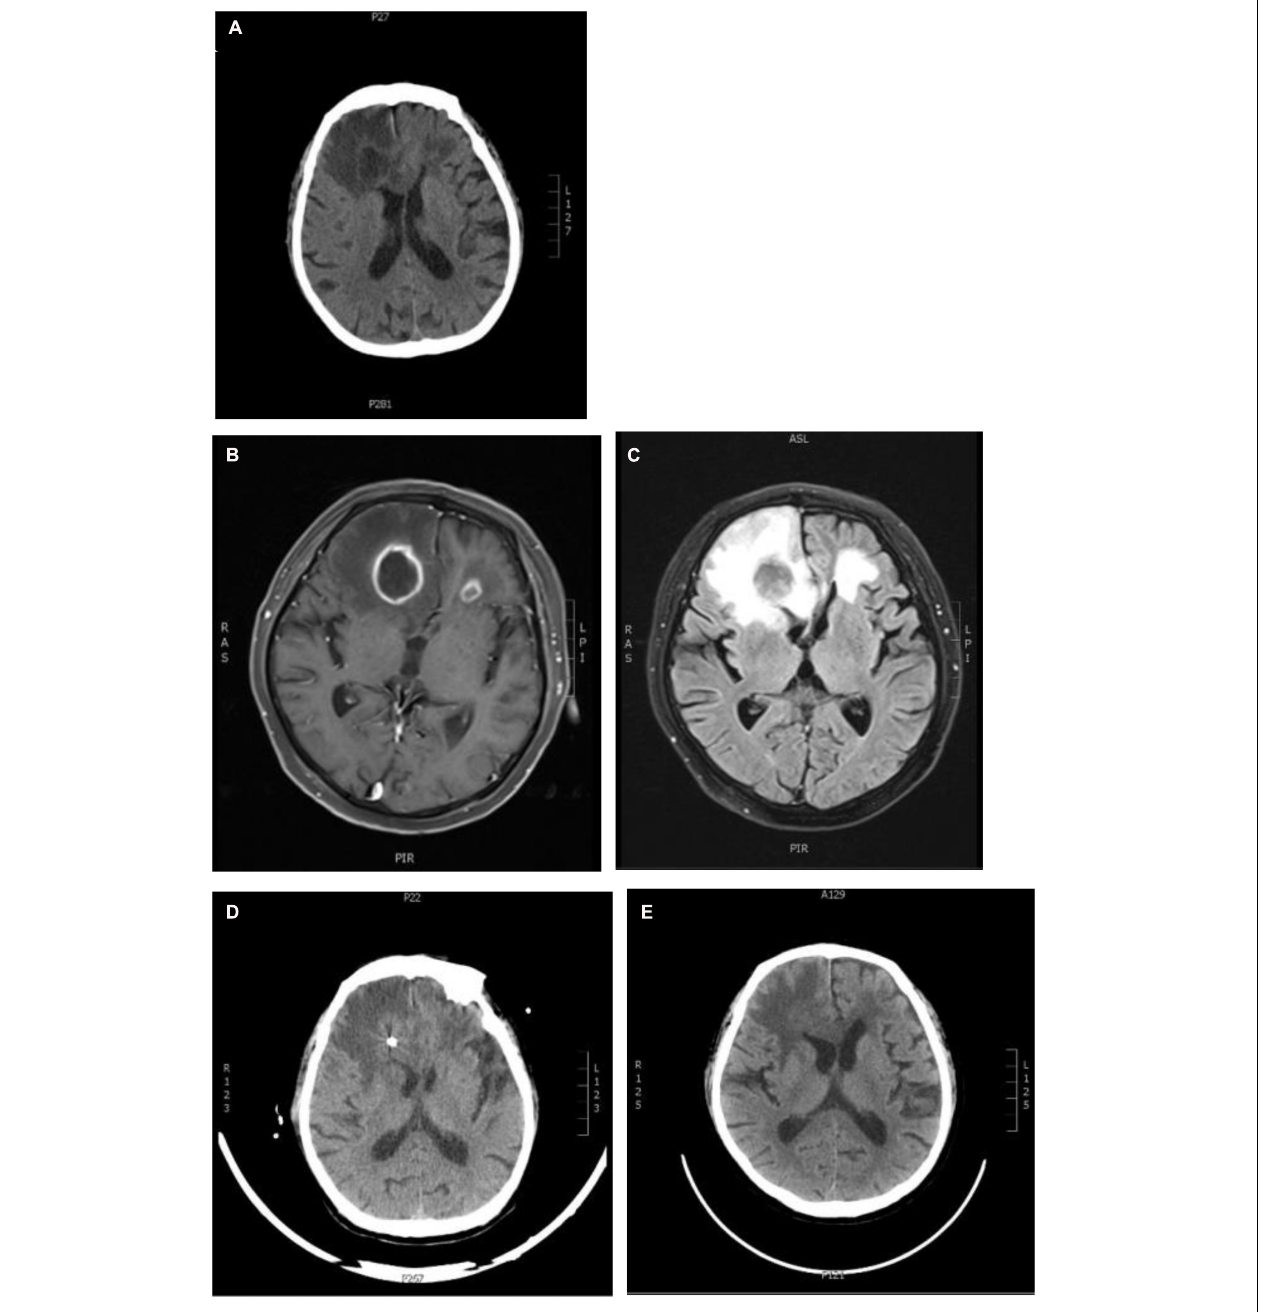
FIGURE 5 | Changes in brain imaging. (A) Craniocerebral CT: The patchy low-density shadows were seen in the bilateral frontal and temporal lobes (the right side was the indigenous), and the patchy low-density shadows were also seen in the bilateral basal ganglia and paraventricular zone. The density of white matter in the paraventricular zone was reduced, and there was no abnormal density change in the cerebellum and brainstem; (B,C) craniocerebral MRI + enhancement + diffusion: bilateral frontal lobe abscess; (D,E) craniocerebral CT after abscess puncture and drainage: postoperative changes, bilateral frontal lobe multiple enhancement lesions, and some lesions